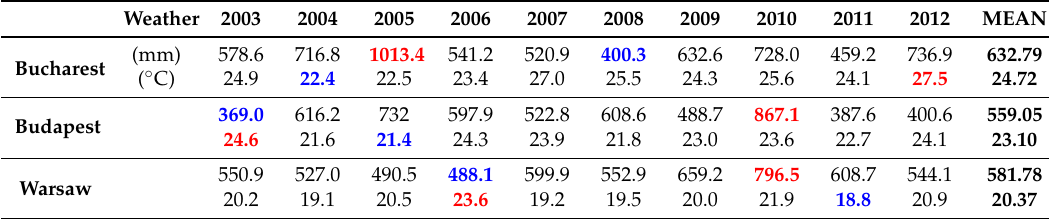
Table 4. Accumulated annual precipitation (mm) and maximum air temperature for each city ( ◦ C). Red color indicates the maximum value and blue color the minimum value in the annual time